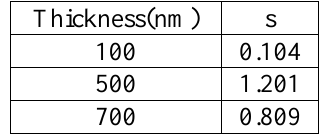
Table 2: The values of s for Bi